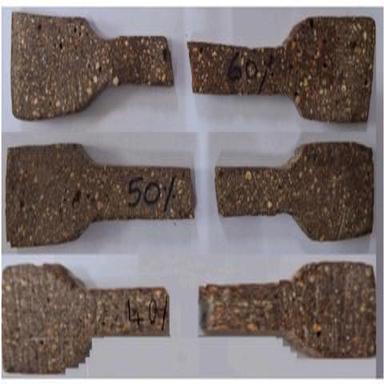
Specimens of Citrus limetta peel powder fiber composite with different volume fractions (%) for tensile test.